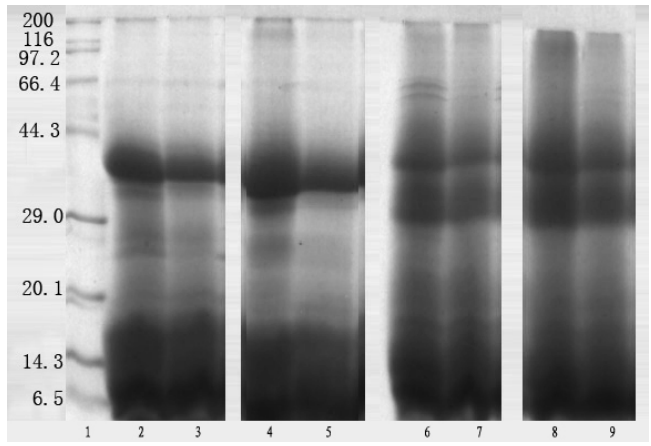
Figure 4 . SDS-PAGE of wort proteins under reducing and non-reducing conditions: 1. Marker (kDa); 2. Baudin wort before boiling (with 2-ME); 3. Baudin wort after boiling (with 2-ME); 4. Guangmai wort before boiling (with 2-ME); 5. Guangmai wort after boiling (with 2-ME); 6. Baudin wort before boiling (without 2-ME); 7. Baudin wort after boiling (without 2-ME); 8. Guangmai wort before boiling (without 2-ME); 9.